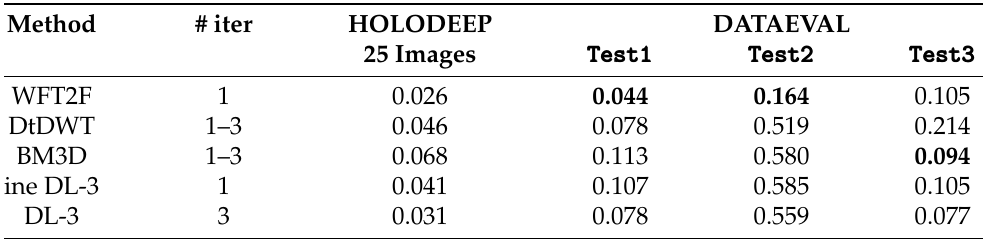
Table 1. Baseline standard deviation of the phase errors ( ∆ φ in rad) obtained on the 25 images from the HOLODEEP database (in average) and individual images from DATAEVAL. Iter is the number of times that the image passes through the de-noiser.